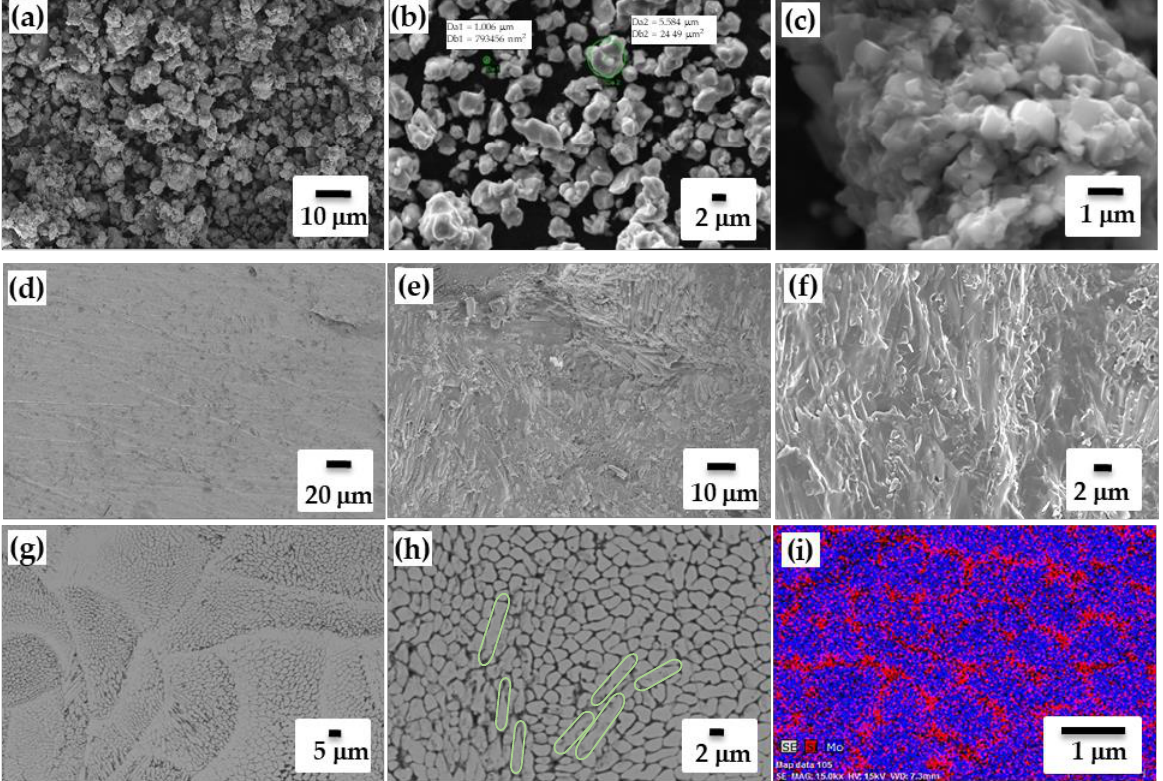
Figure 1. SEM images of MoSi 2 -10 wt.% Si powder ( a – c ); SEM images of the surface ( d , g , h ); and cross-section ( e , f ) with different magnifications, EDS mapping of surface ( i ).